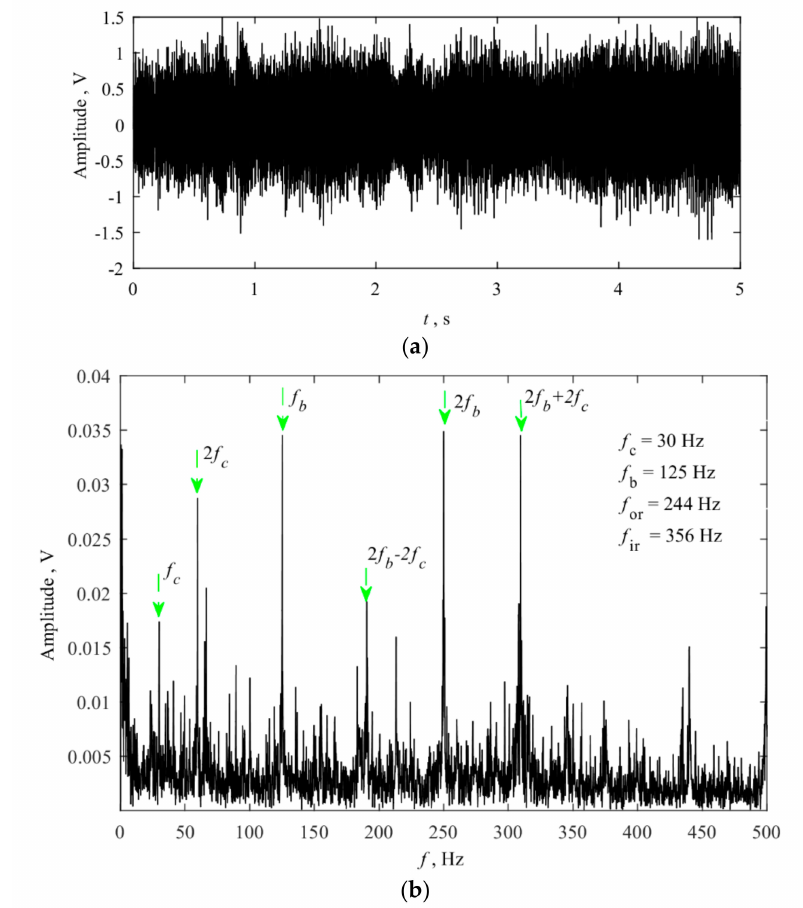
Figure 19. The vibration signal of MWA #1: ( a ) time domain waveform; ( b ) envelope